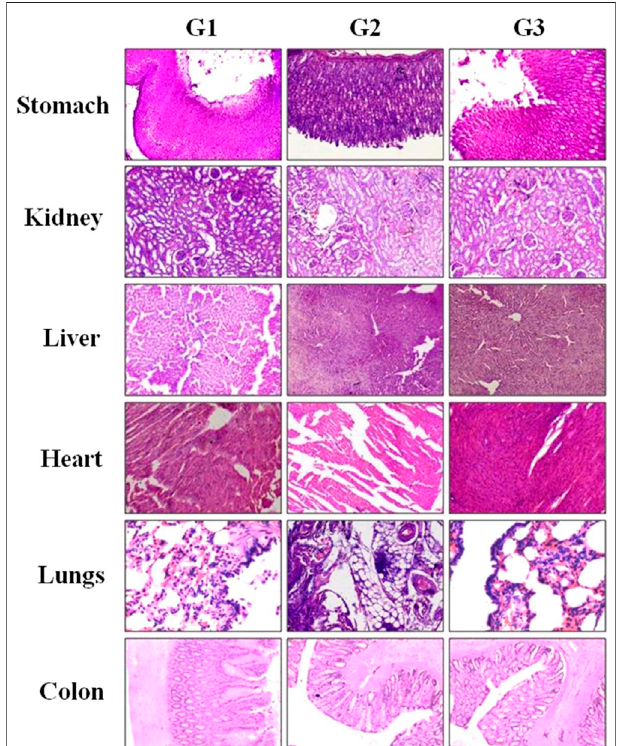
FIGURE 4 | Histopathological observation of major tissues obtained from GIT and other major organs of Charles Foster rats fed with (G1) vehicle